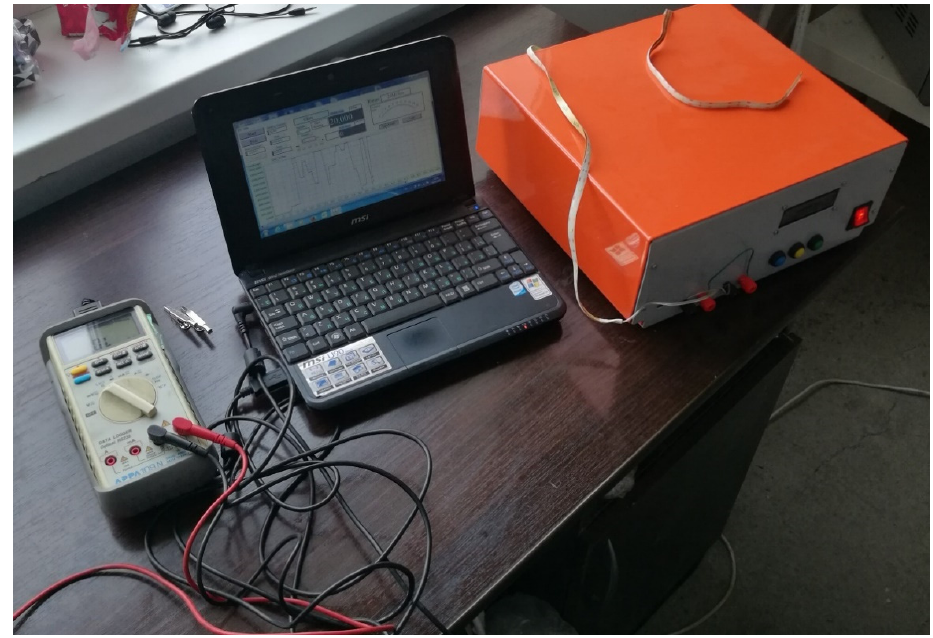
Figure 4. Experimental setup made up of a (from left to right) multimeter, laptop computer and the newly built WEC emulator.